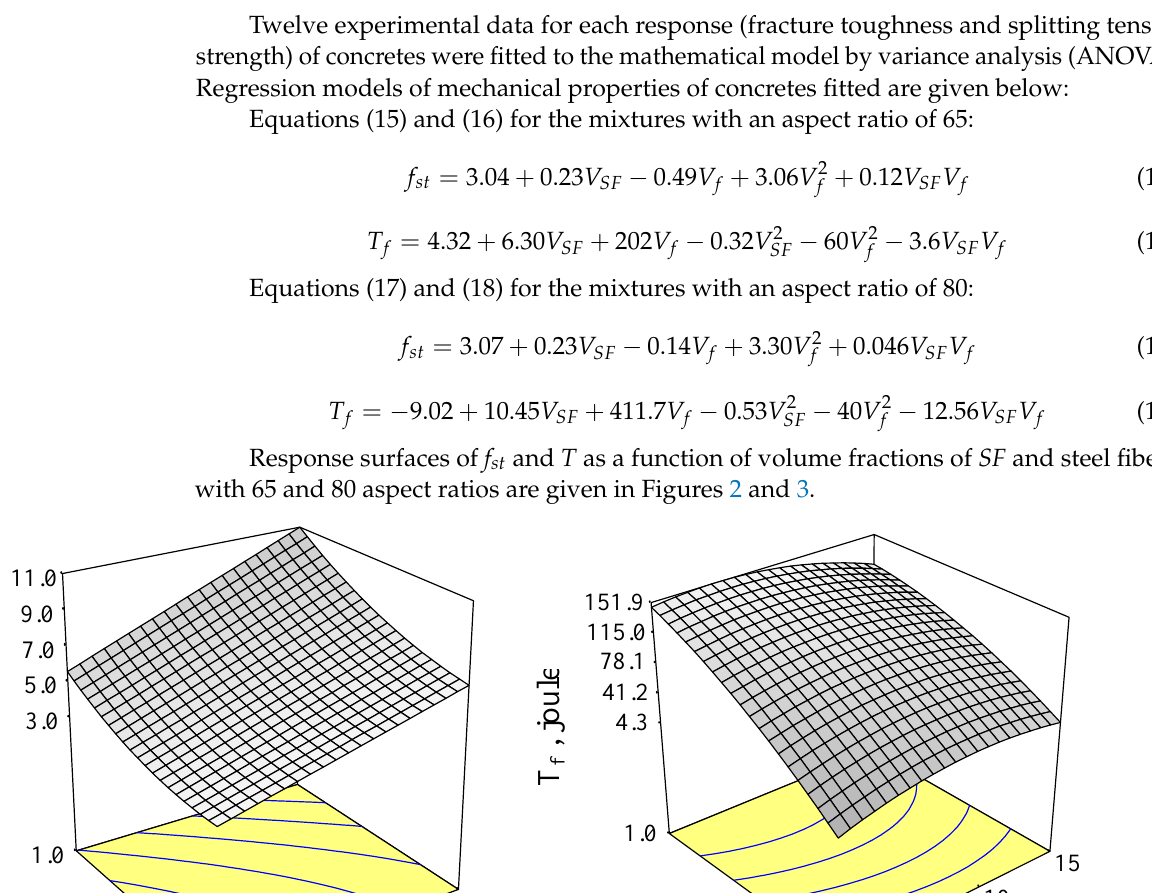
Figure 2. Response surfaces of f st and T for the fiber aspect ratio of 65.